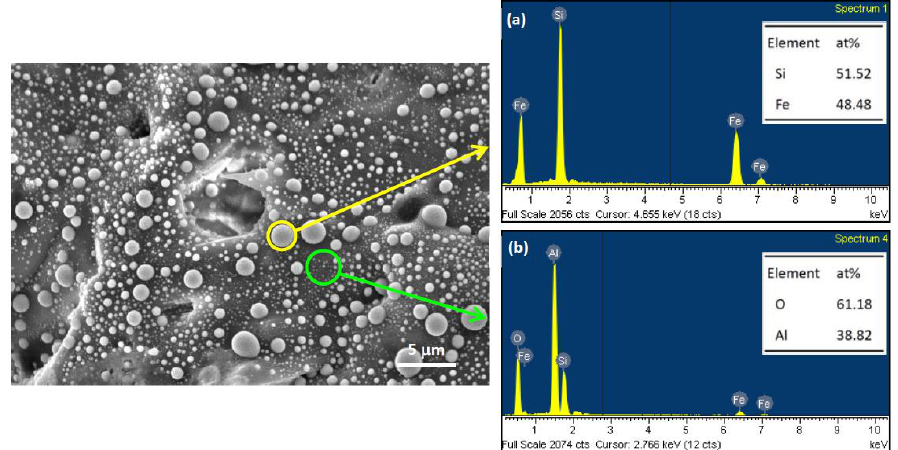
Figure 9. SEM image and EDS spectra associated with ( a ) FeSi and ( b ) Al 2 O 3 of SHS-derived product from Reaction (1) with x = 3.0.